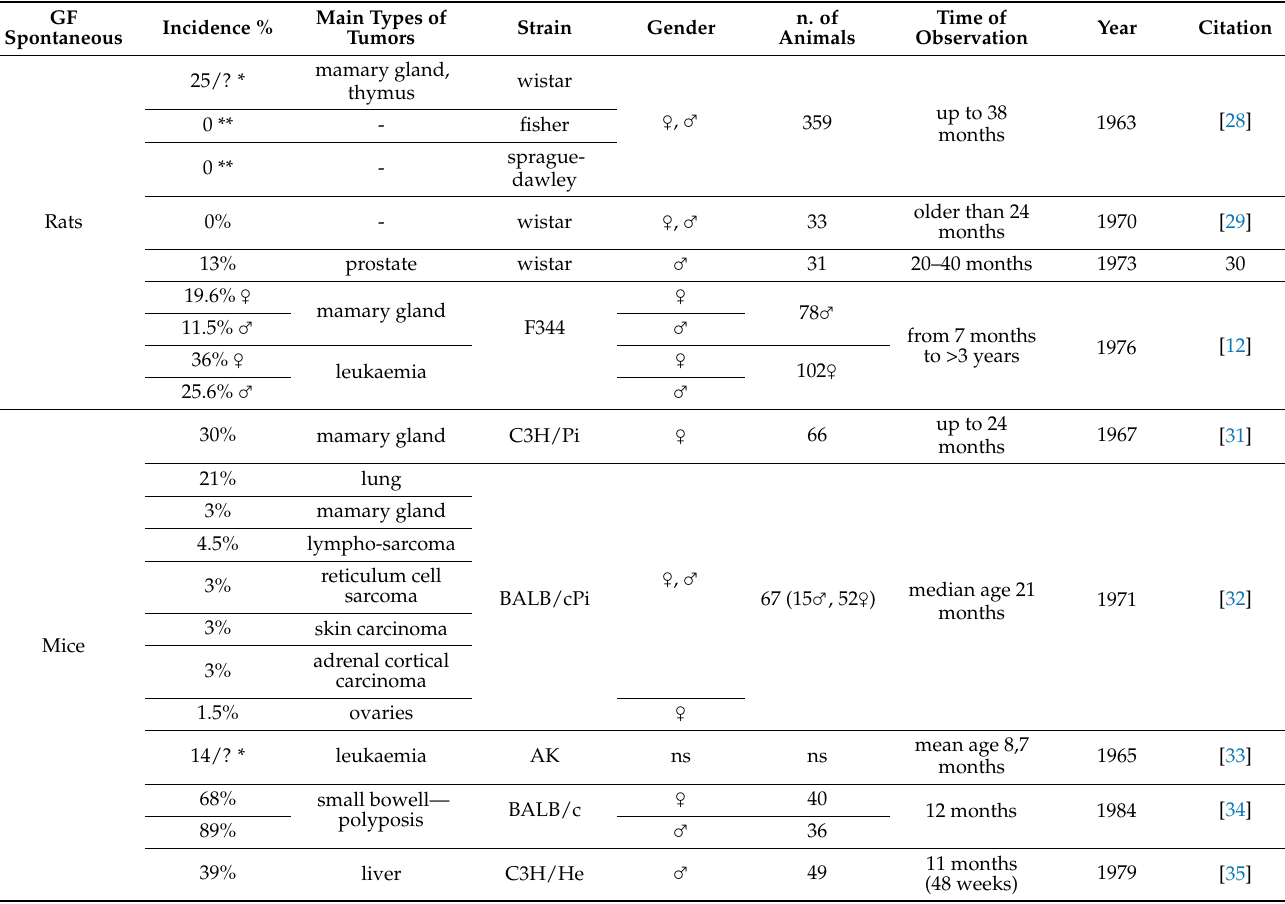
Table 2. Spontaneous tumors in germ-free (GF) experimental rats and